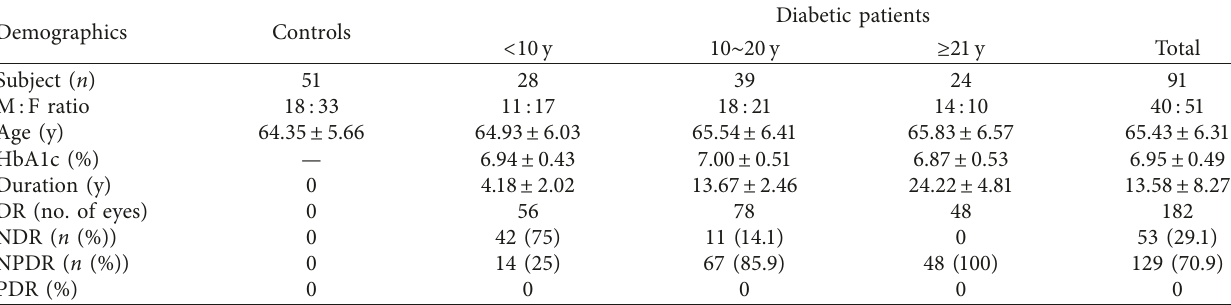
Table 2: Demographics of diabetic subgroups and control